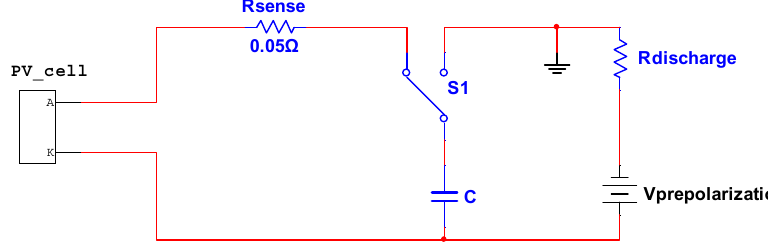
Figure 12. Pre-polarized capacitor implementation [81].